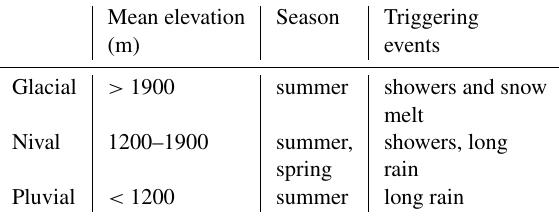
Table 2. Hydrological regimes and characteristics of extreme floods in Switzerland (Froidevaux,